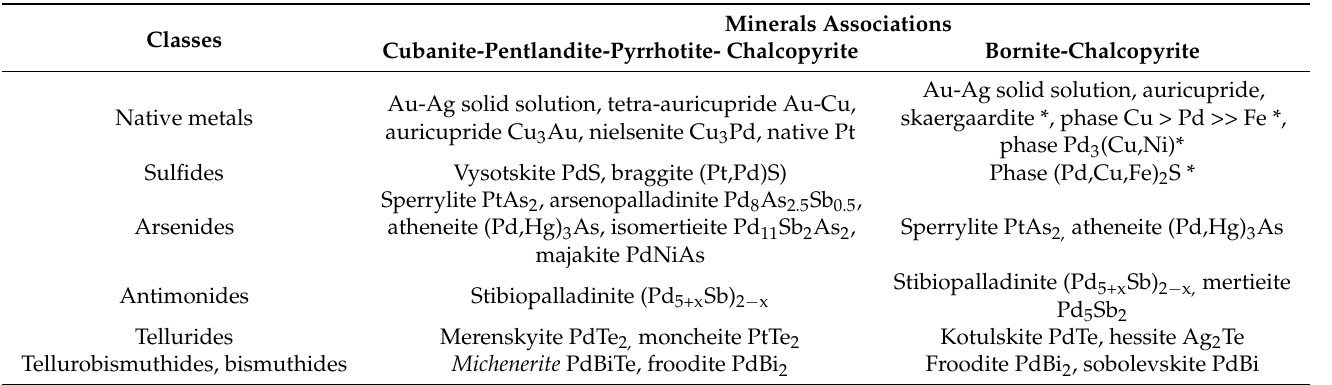
Table 13. Noble metal minerals at Ozernoe occurrence from [8,10].